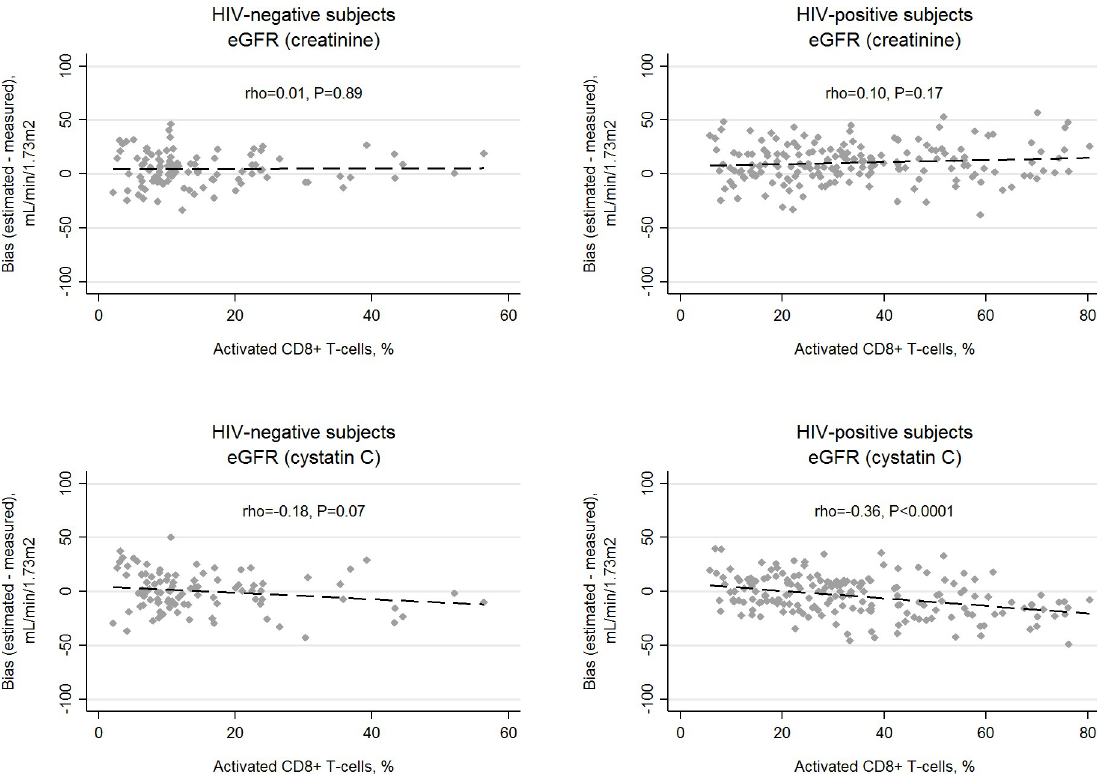
Fig 3. Correlation of estimated glomerular filtration rate (eGFR) bias, defined as the difference between eGFR and measured GFR, with percentage of activated CD8 T cells (CD38+ and HLA-DR+) using the creatine-based CKD-EPI equation in HIV-negative (A) and HIV-positive (B) subjects, and the cystatin C-based CKD-EPI equation in HIV negative (C) and HIV-positive (D) subjects. The percentage of CD8+ T cells with an activated phenotype is shown on the X axes (note, different scales for HIV-positive and HIV-negative groups). Rho is the spearman rank correlation coefficient, which may vary between -1 and 1. The dashed lines represent least-squares regression lines.